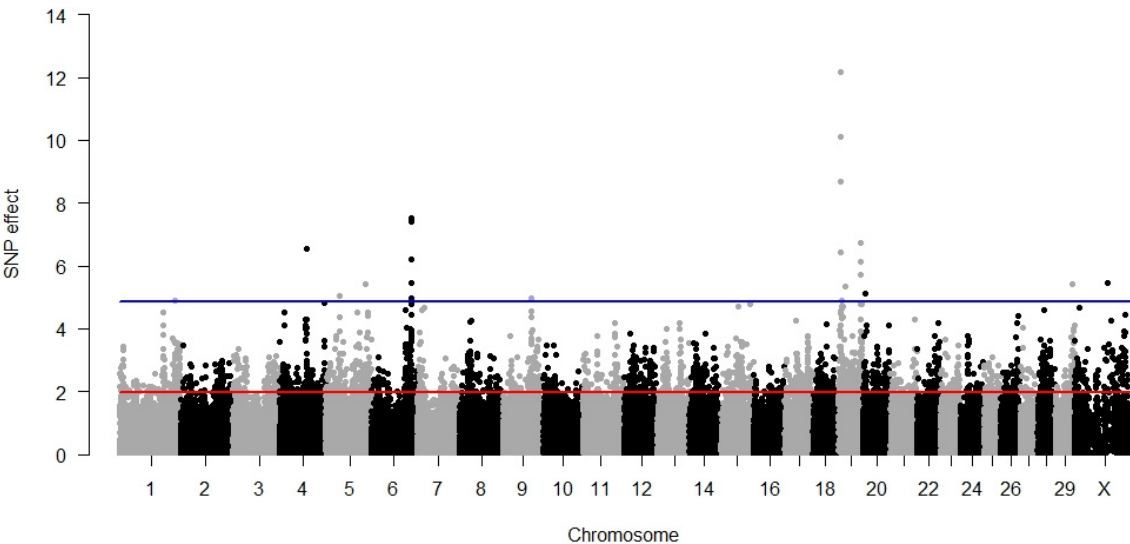
Figure 6. GWAS results for milking speed. The red line (1.96) represents a nominal and the blue line (4.88) a Bonferroni-corrected critical value corresponding with a 5% significance level.